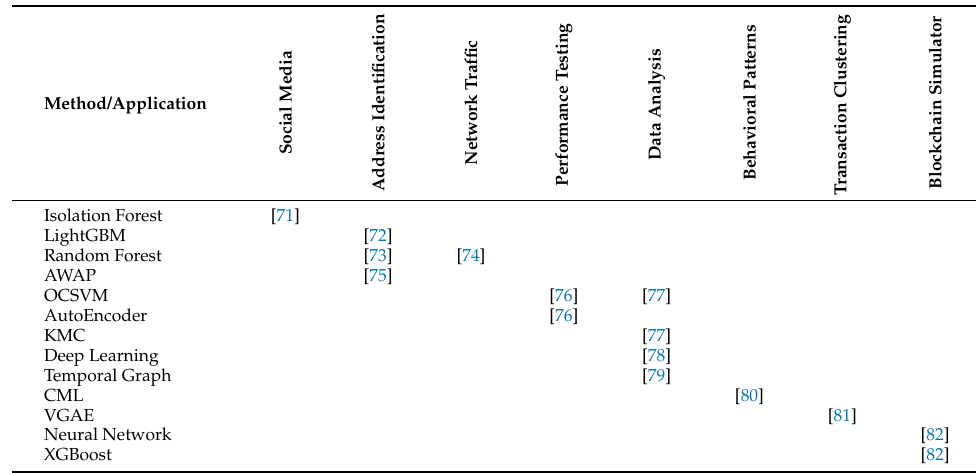
Table 5. Anomaly detection in data